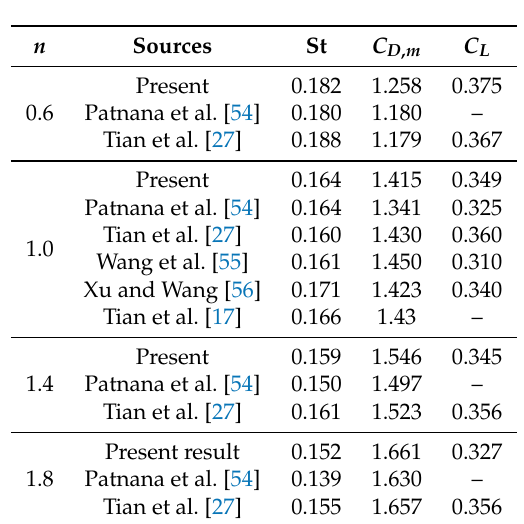
Figure 4. Geometry-adaptive mesh strategy. Table 2. A uniform flow over a stationary cylinder at Re = 100. St: Strouhal number; C D , m : drag coefficient; C L : lift